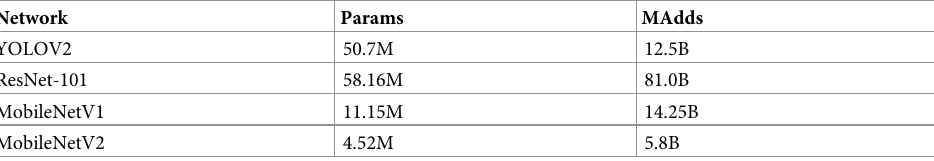
Table 1. Comparison of parameters and complexity of different network structures in feature extraction.